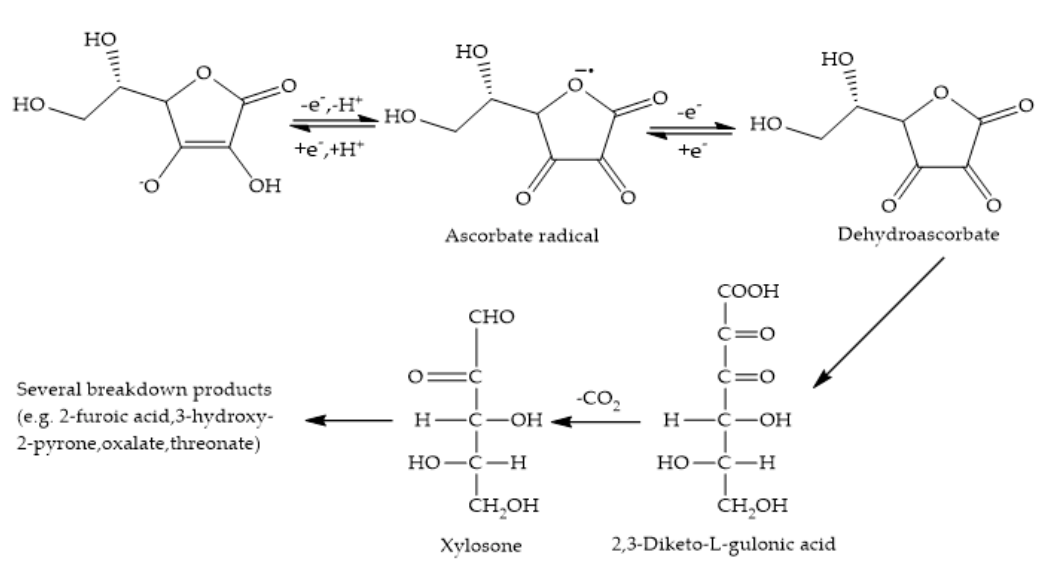
Figure 2. Structure of ascorbate and its oxidation and degradation products [23].